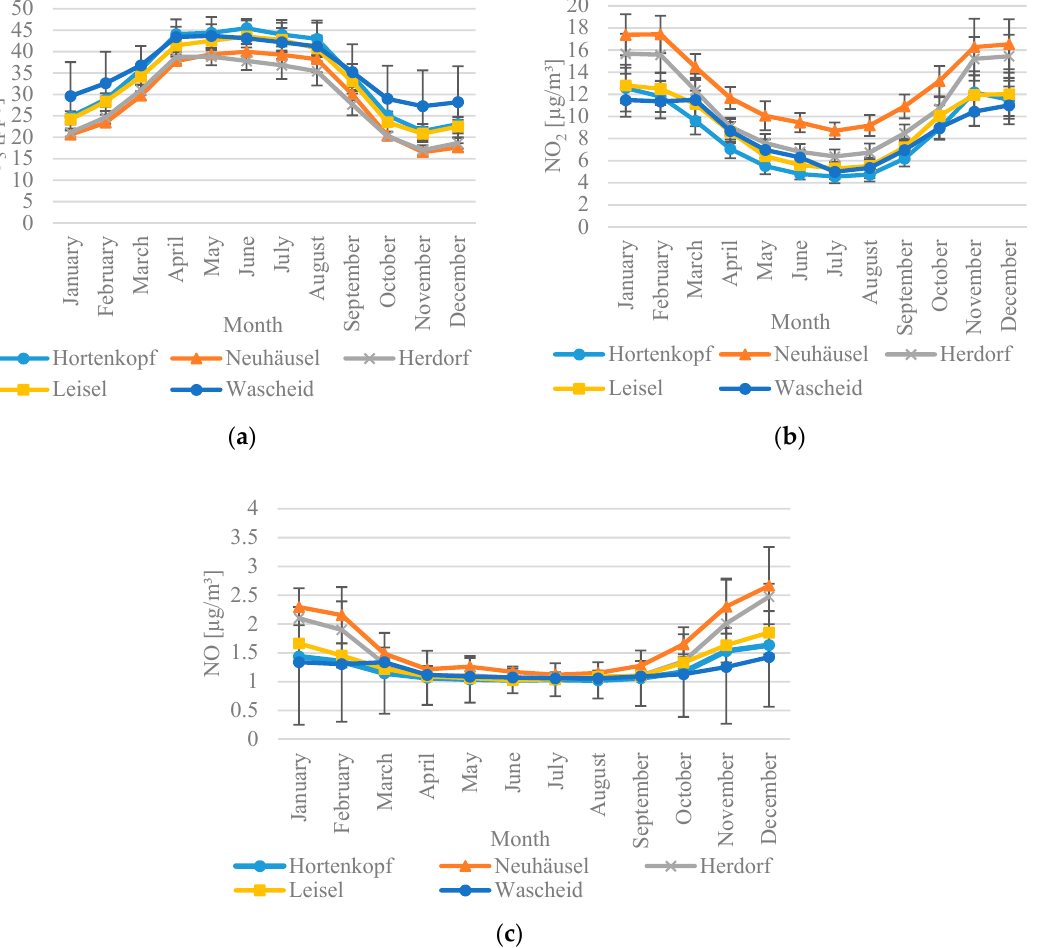
Figure 4. Monthly mean values and standard deviation of ( a ) O 3 , ( b ) NO 2 and ( c ) NO concentrations with 95% confidence intervals at the five monitoring sites, averaged over the period 1998–2019.